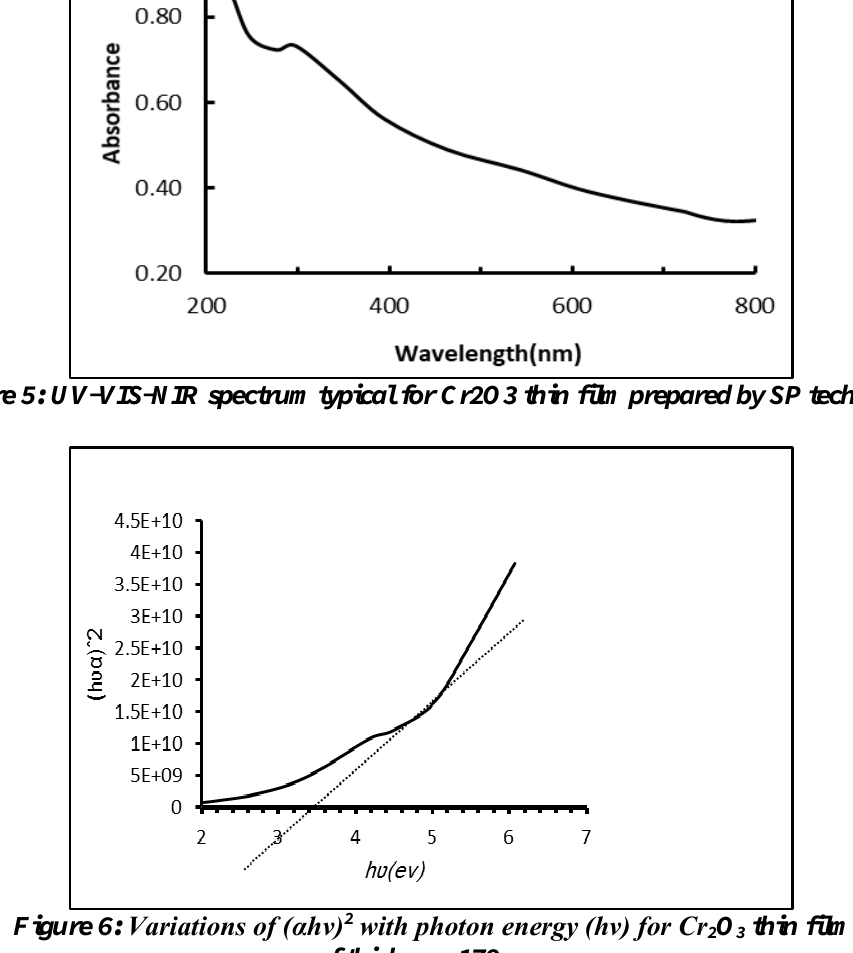
of thickness 170